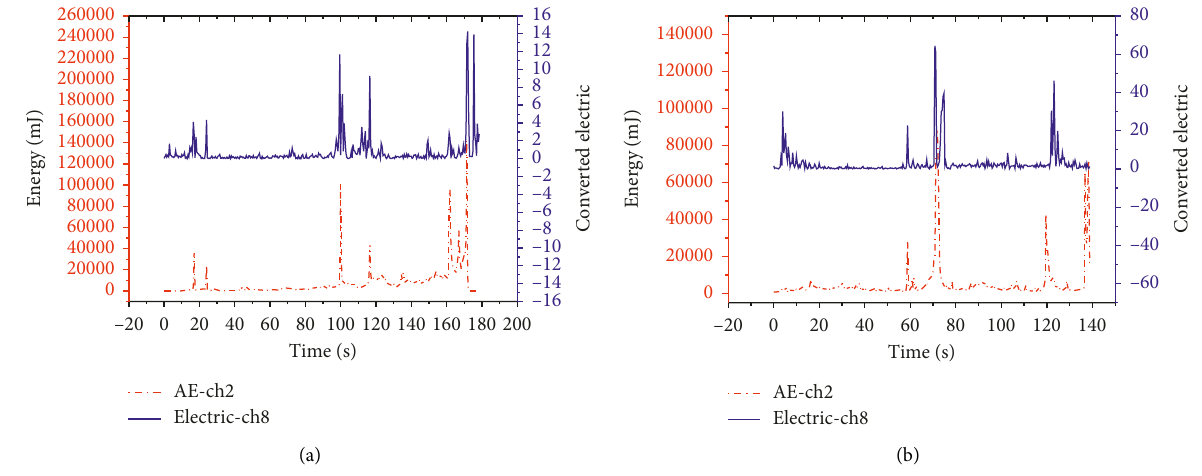
Figure 10: Correlation between AE energy and converted electric